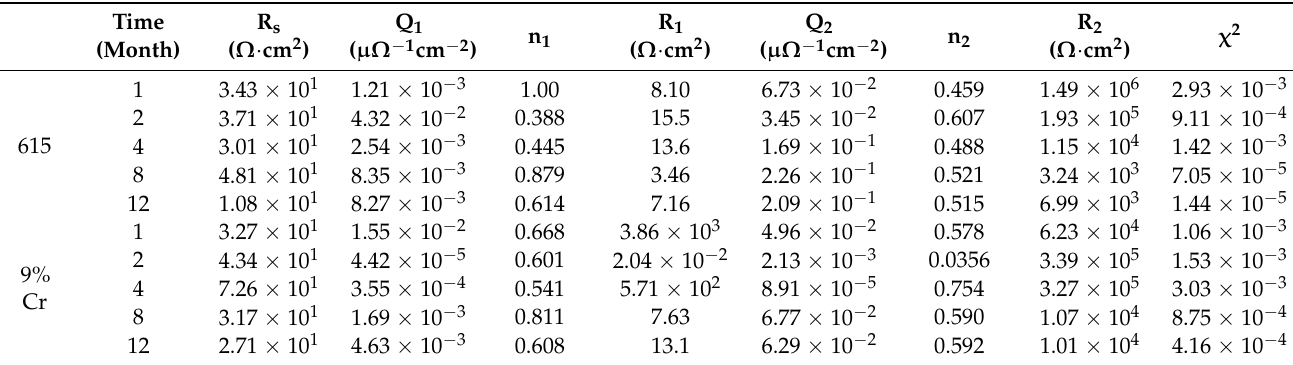
Figure 9. Equivalent circuit used for EIS fitting. Table 3. Best fitting